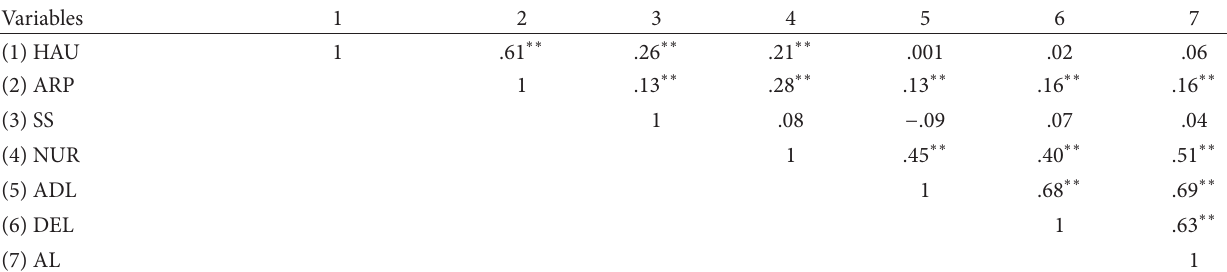
T 2: Correlations among predictors and